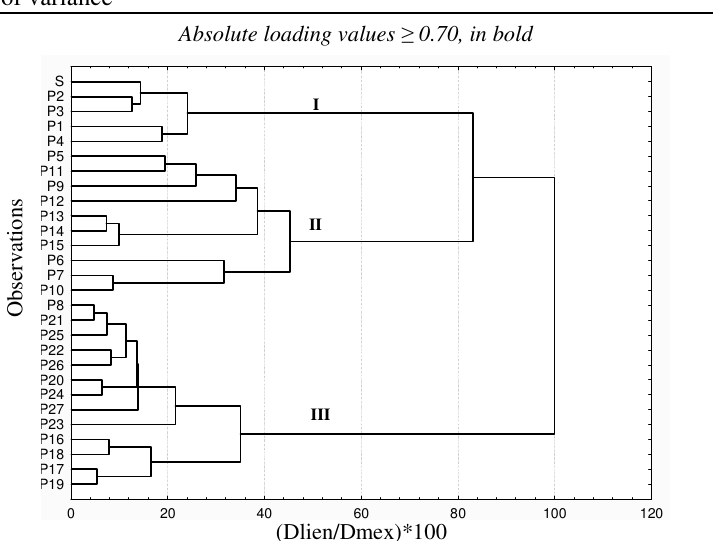
Figure 2. Ward’s dendrogram of the groundwater